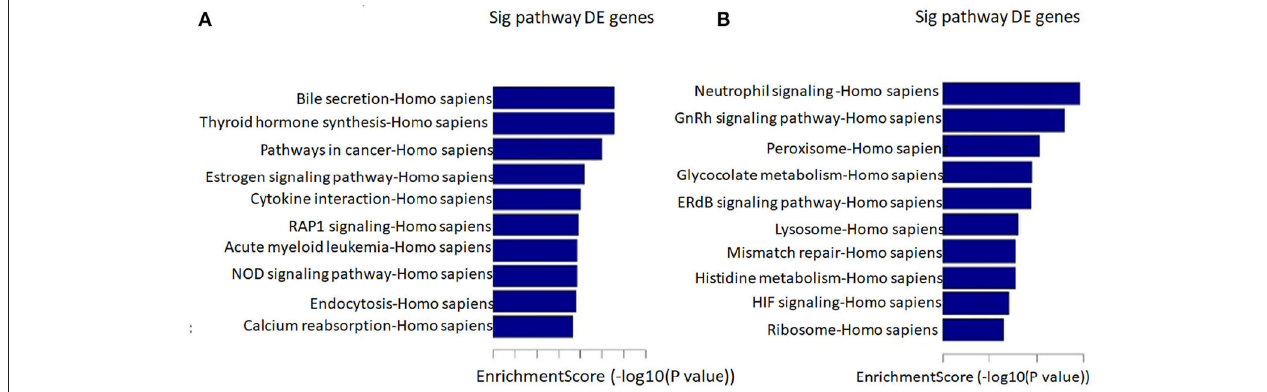
FIGURE 4 | Pathway analysis. The top 10 pathways that associated coding gene of up-regulated lncRNAs (A) and downregulated lncRNAs (B) are listed.